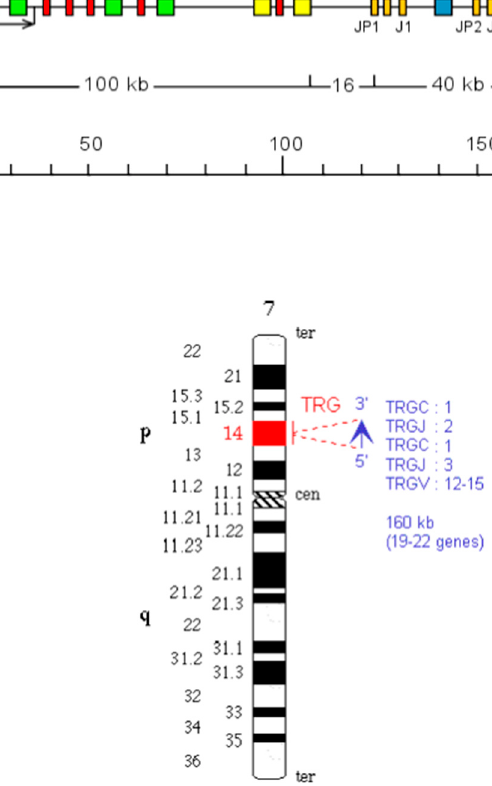
Figure 1. Human (Homo sapiens) TRG locus representation ( A ) and chromosomal localization ( B ), reproduced with permission from IMGT ® (http://www.imgt.org). In ( A ), colors are according to IMGT color menu for genes (https://www.imgt.org/IMGTScientificChart/RepresentationRules/colormenu.php#LOCUS). The boxes representing the genes are not to scale. Exons are not shown. A double arrow indicates insertion/deletion polymorphisms. The Amphiphysin ( AMPH ) (IMGT 5 ′ borne) was identified 16 kb upstream of TRGV1 (ORF), the most 5 ′ gene in the locus, and the Related to steroidogenic acute regulatory protein D3-N-terminal like ( STARD3NL ) (3 ′ IMGT borne) was identified 9.4 kb downstream of TRGC2 (F), the most 3 ′ gene in the locus. In ( B ), a vertical red line indicates the localization of the TRG locus at 7p14. A blue arrow indicates the orientation 5 ′ → 3 ′ of the locus, and the gene group order in the locus. The blue arrow is proportional to the size of the locus, indicated in kilobases (kb). The total number of genes in the locus is shown in parentheses.